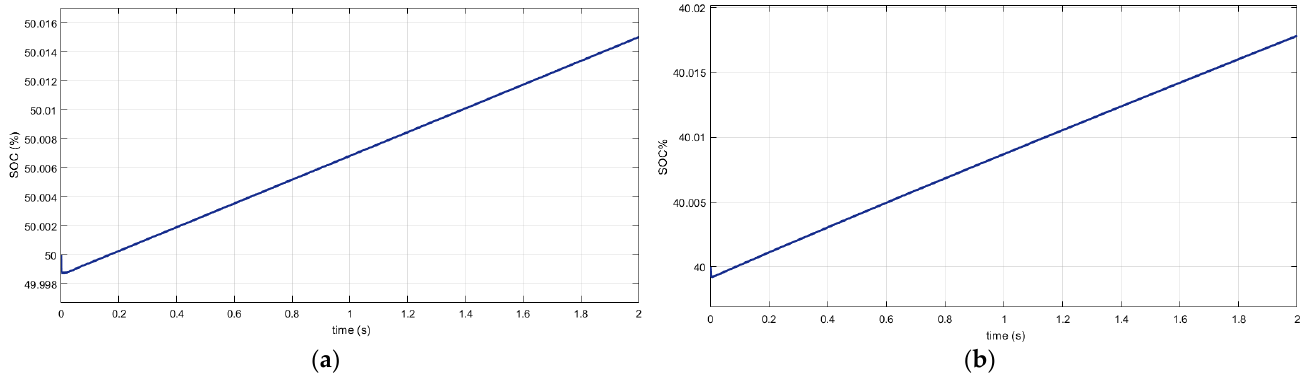
Figure 8. EV and ba tt ery charging from PV. ( a ) EV SOC. ( b ) ba tt ery SOC.